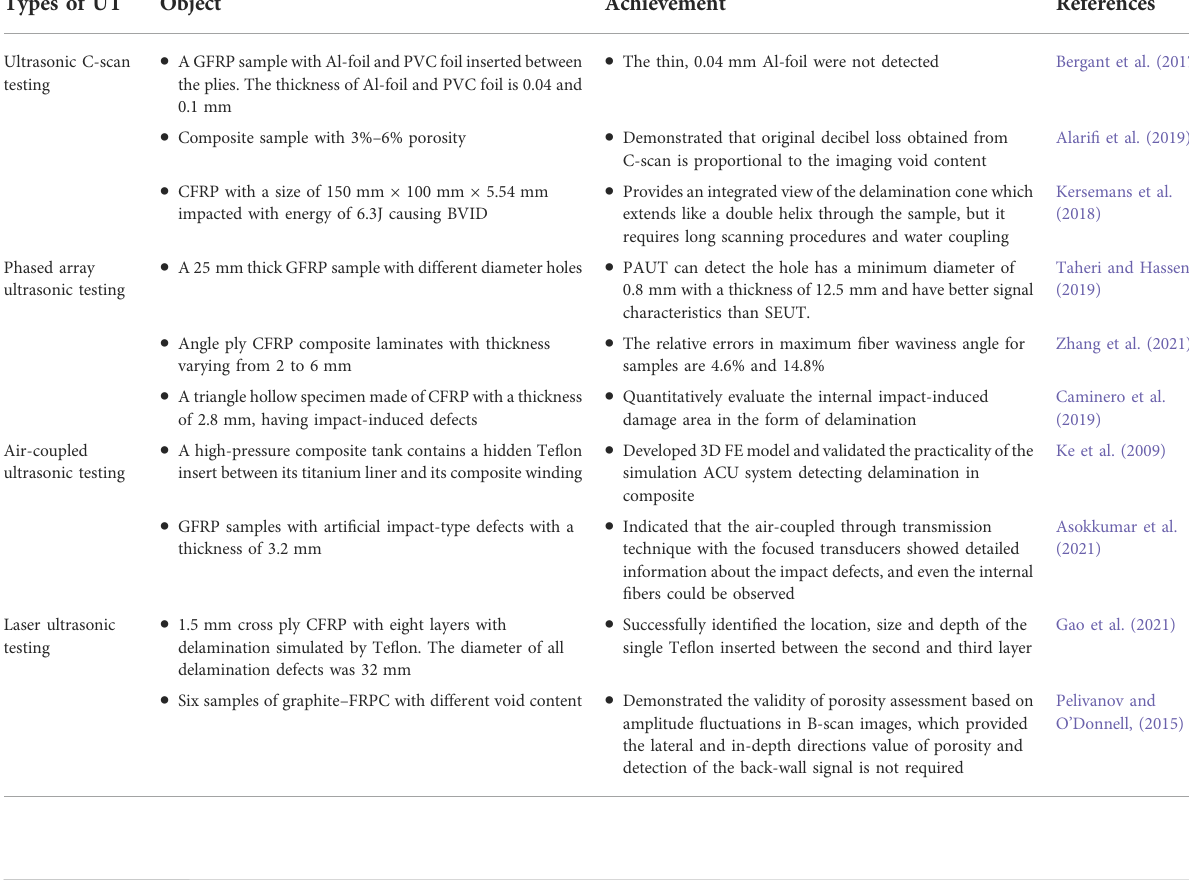
TABLE 1 Summary of typical types of UT applications for the detection and evaluation of FRPCs.